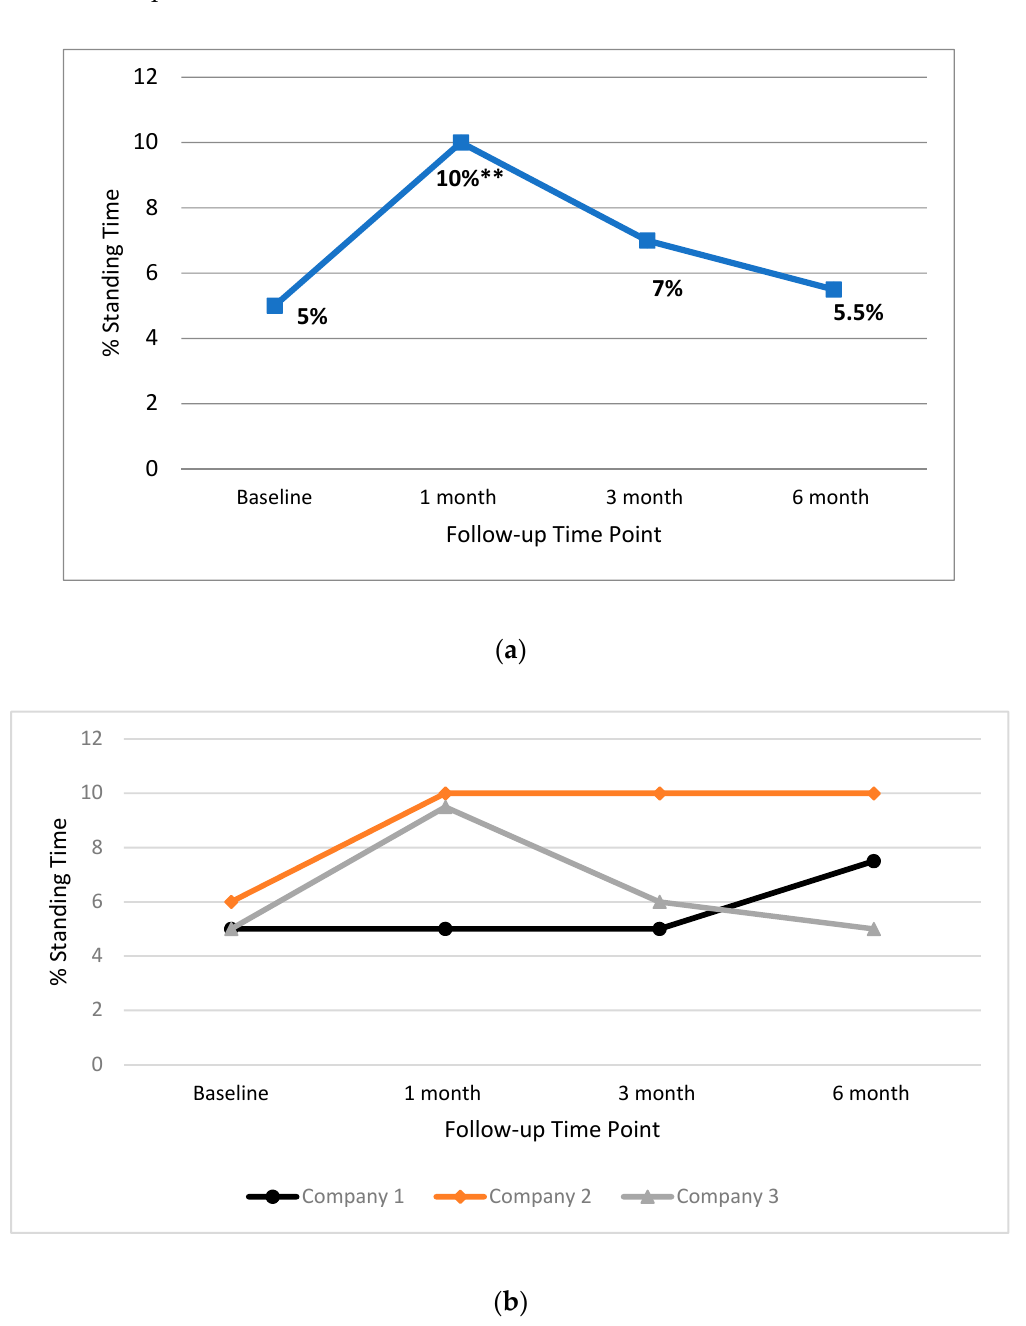
Figure 3. Median percentage workplace standing time for the total group ( a ) and individual companies ( b ) at baseline, one month, three month and six month time points. ** = significant